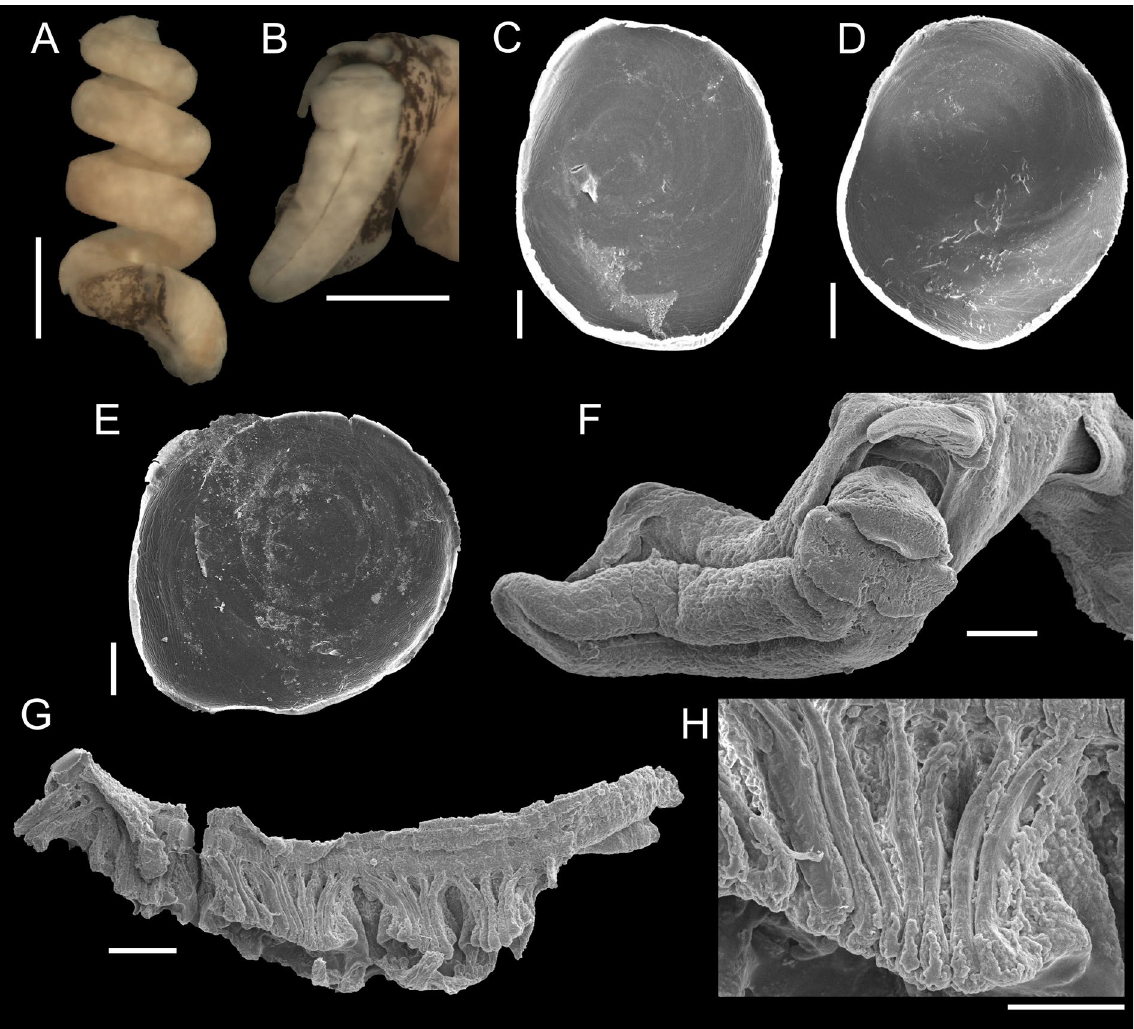
Fig. 25. Similiphora intermedia (C.B. Adams, 1850). A–C, F–H . MNRJ 30854. D . MNRJ 18751. E . MNRJ 29763. A–B . External morphology. C–E . Operculum. F–H . Head-foot (F) and ctenidium (G–H) critical-point dried. Scale bars: A–B = 500 µm; C–G = 100 µm; H = 50